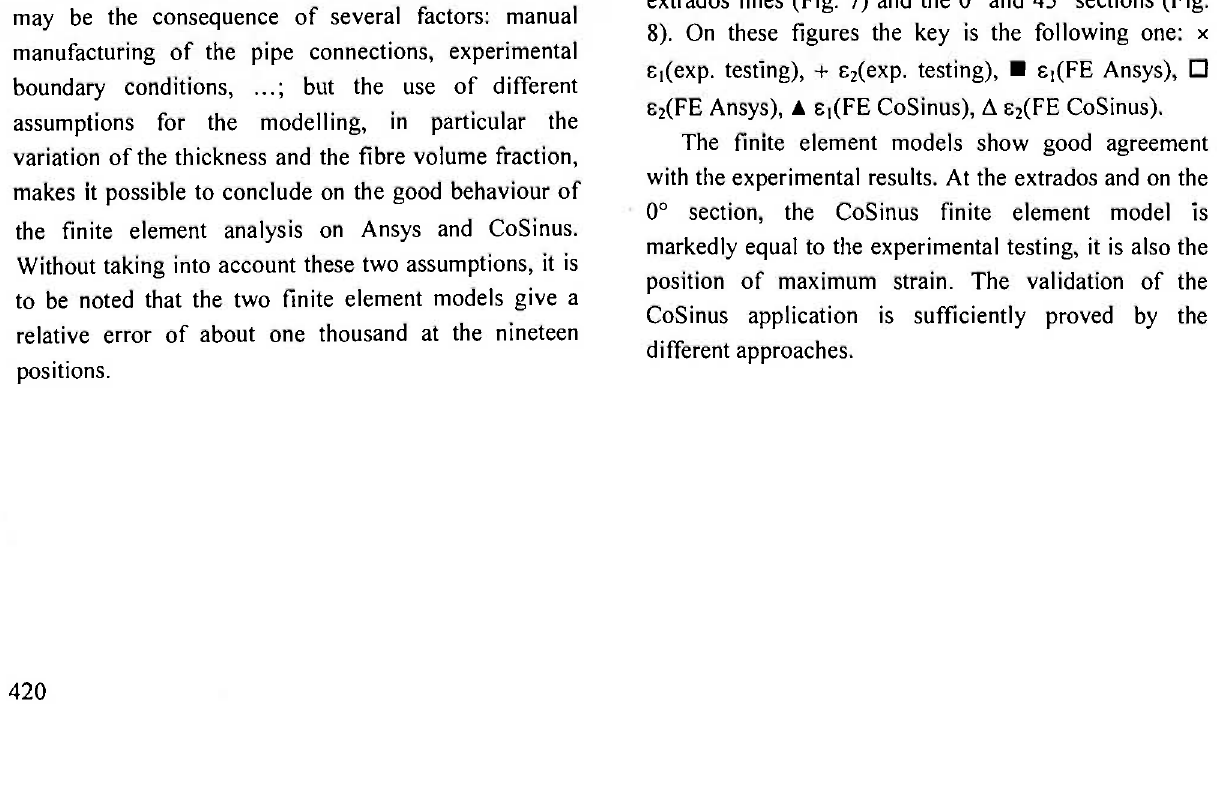
Fig. 6: Failure criteria at 72 bars (left) and 80 bars